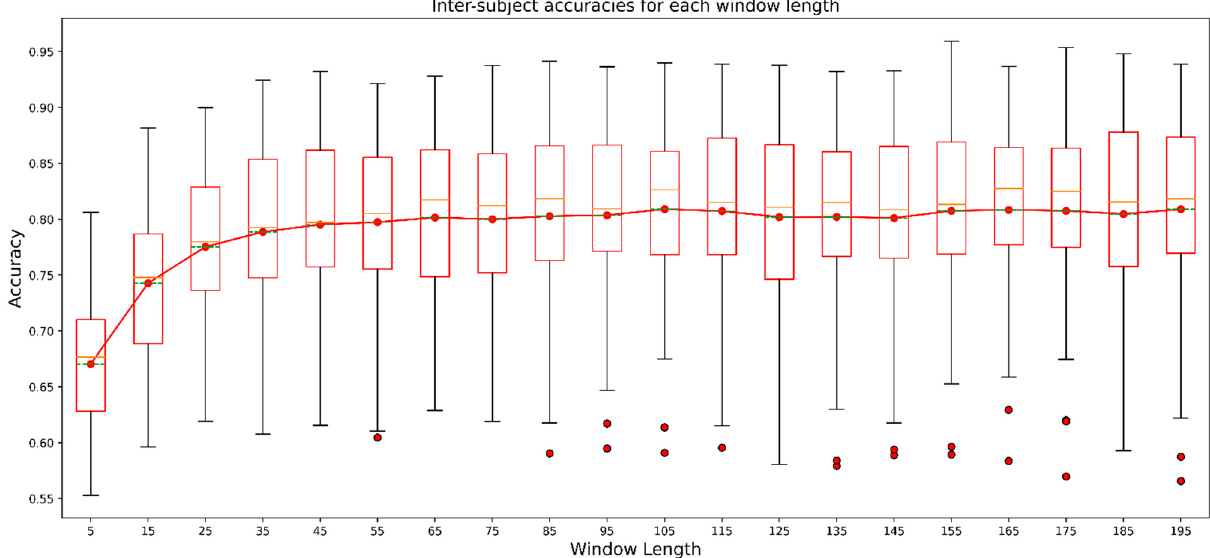
Figure 8. Box plot showing spreads of results for each participant for all window lengths. The red line connects the points indicating average accuracy at each window length. The red horizontal line in the bar denotes the median values whereas the green dashed horizontal line denotes the average values.